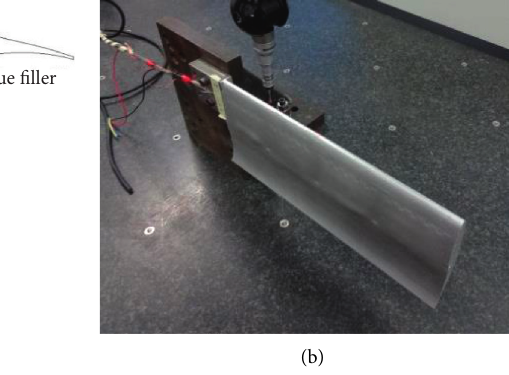
Figure 1: Sketch of the